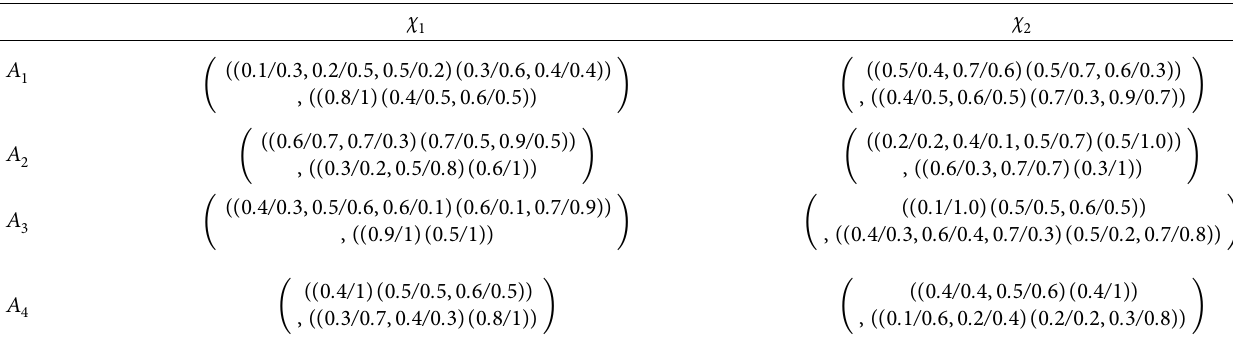
Table 1: Expert information.